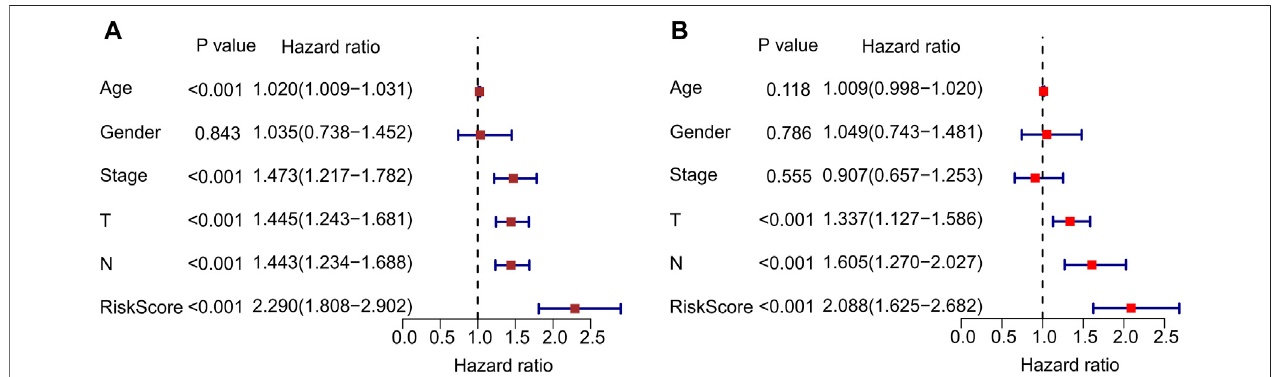
FIGURE 6 | Independent prognostic analysis of autophagy-related lncRNAs. (A) Univariate cox regression analysis shows the correlation between overall survival and clinicopathological parameters include age, stage, T stage, N stage and the autophagy-related lncRNAs prognostic signature risk score. (B) Multivariate cox regression analysis reveals that T stage, N stage, and risk score are independent prognostic indicators for overall survival rates of CM patients.